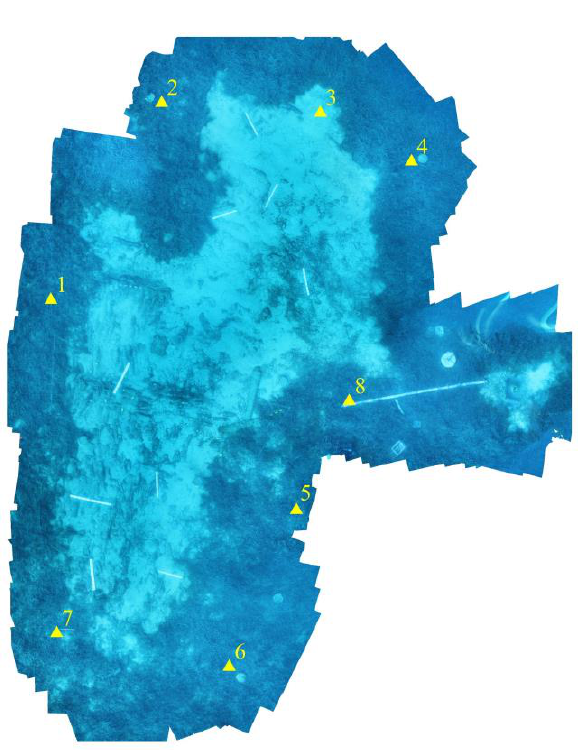
Figure 1. Overview orthophoto of the shipwreck site and overlaying control points.